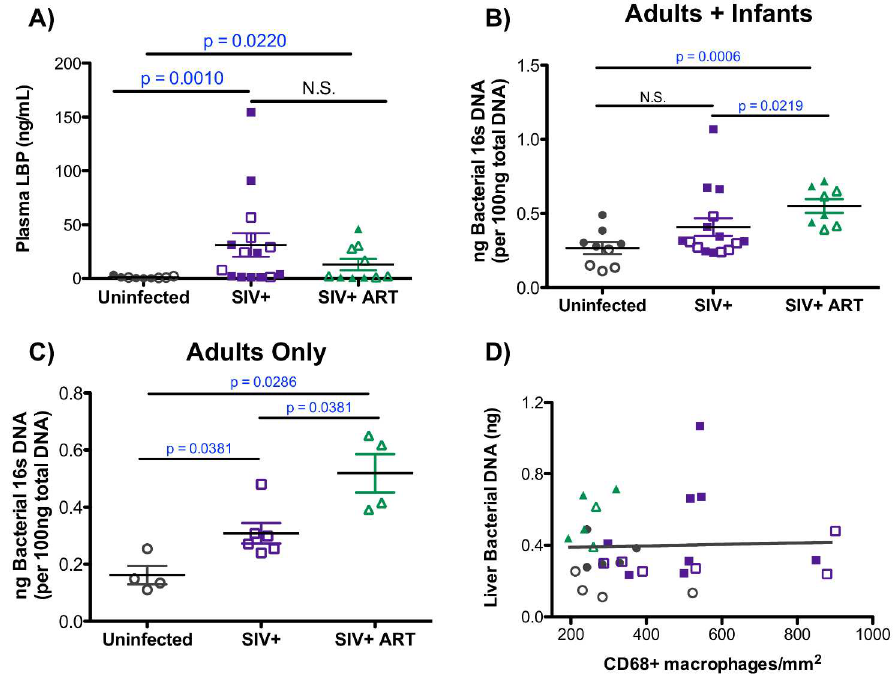
Fig 5. Levels of microbial products in the liver and in the plasma during SIV infection. A) Plasma LBP levels were quantified in duplicate for each macaque by ELISA. Data are graphed as the mean LBP concentration (ng/mL) for each macaque ± SEM. Statistical significance was determined by Mann Whitney T tests. B-C) Levels of bacterial 16S DNA was quantified by qPCR for each liver sample assayed in duplicate. Nanograms (ng) of bacterial DNA present in 100 ng of total input DNA was determined using a standard curve and graphed as the mean of each macaque assayed in duplicate ± SEM. Infant (closed symbols) and adult macaques (open symbols) graphed together (B) or adult macaques graphed separately (C). Statistical significance was determined by Mann Whitney T tests. D) Correlation between the levels of 16S DNA in the liver (y-axis) and the number of liver macrophages (x-axis) in uninfected (gray points), SIV- infected (purple symbols), and SIV-infected cART macaques (green symbols) as evaluated by Spearman Correlation